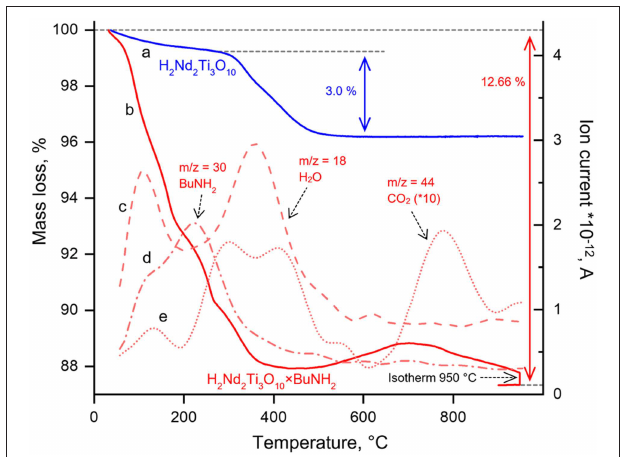
FIGURE 5 | Thermogravimetric curves for H 2 Nd 2 Ti 3 O 10 (a), H 2 Nd 2 Ti 3 O 10 × BuNH 2 (b) and ion currents recorded during simultaneous thermal analysis coupled with mass spectrometry at m/z = 18 (c), m/z = 30 (d), m/z = 44 (e).